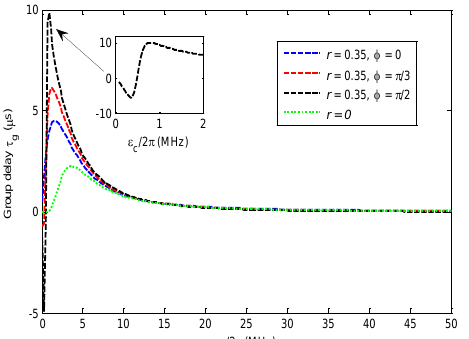
Figure 5. Curves of group time delay τ g vary with the pump-field amplitude 𝜀 𝑐 2𝜋⁄ and driving field amplitude at 𝛥 𝜔 𝑚 ⁄ = 0.99 for different phase differences. The other parameters are the same as those in Figure 2.